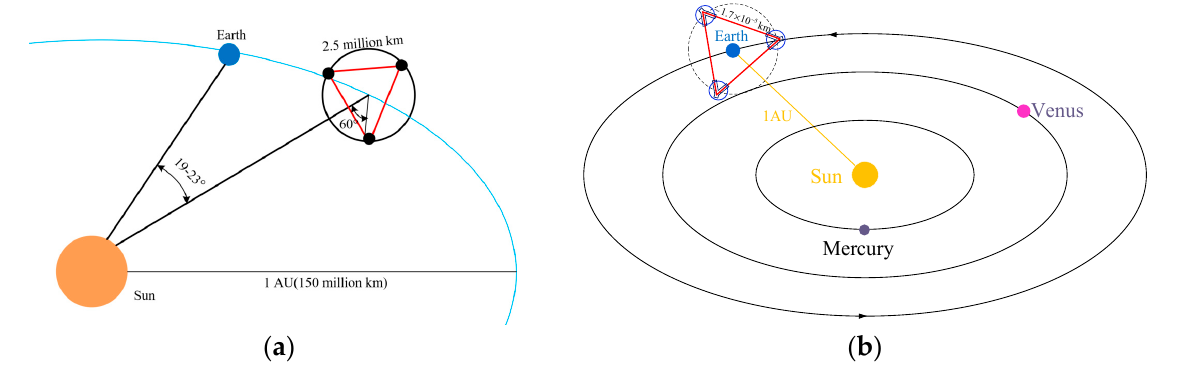
Figure 1. Orbital configuration of the LISA mission and the TianQin project. ( a ) LISA mission [5]. ( b ) TianQin project.